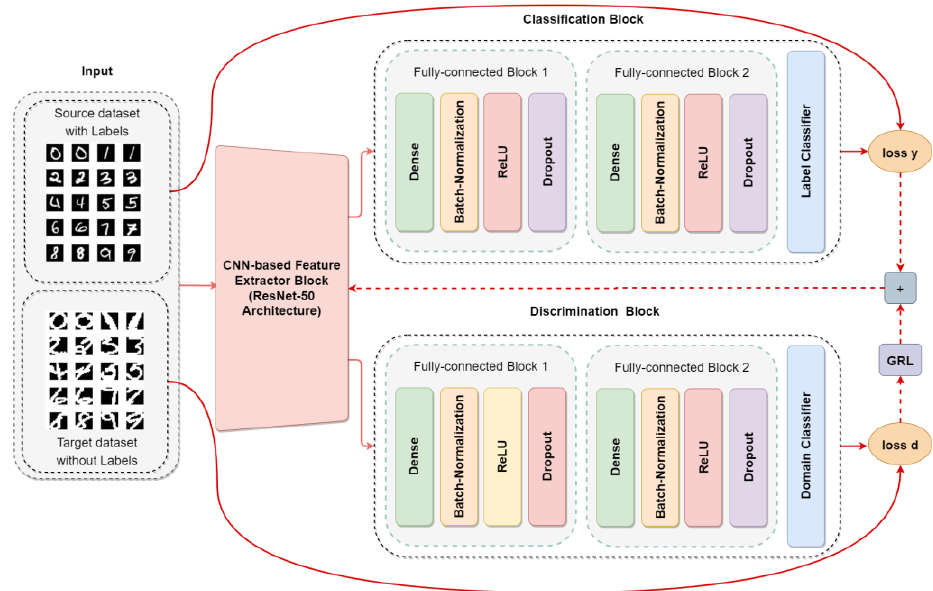
Figure 1. Proposed framework. Forward pass (solid line), backward pass (dashed line), GRL (gradient reversal layer), + (weighted sum of gradients).